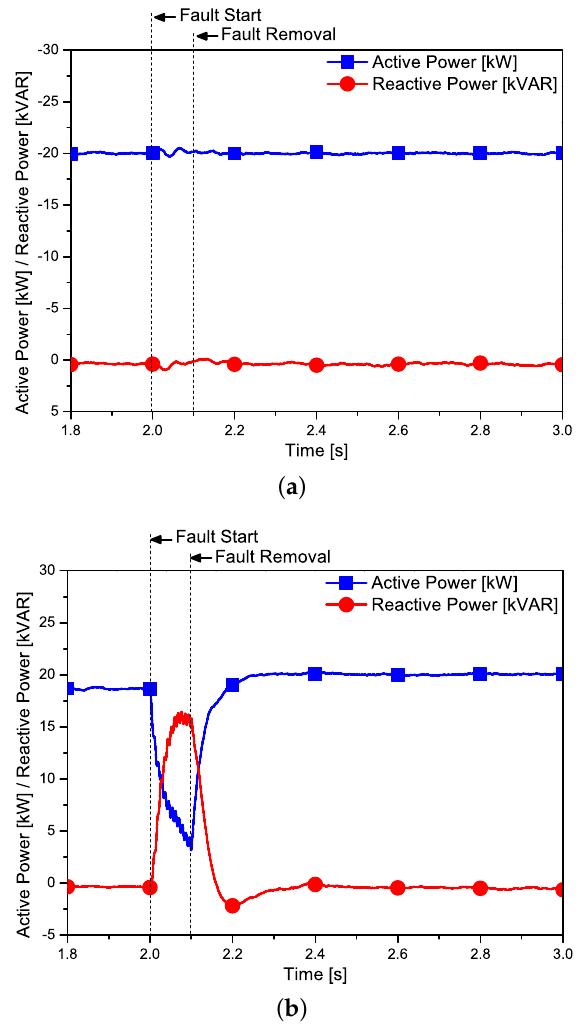
Figure 10. The input power and output power of the MVDC during the grid fault. ( a ) The input power of the MVDC during the grid fault (WSC); ( b ) the output power of the MVDC during the grid fault (GSC).